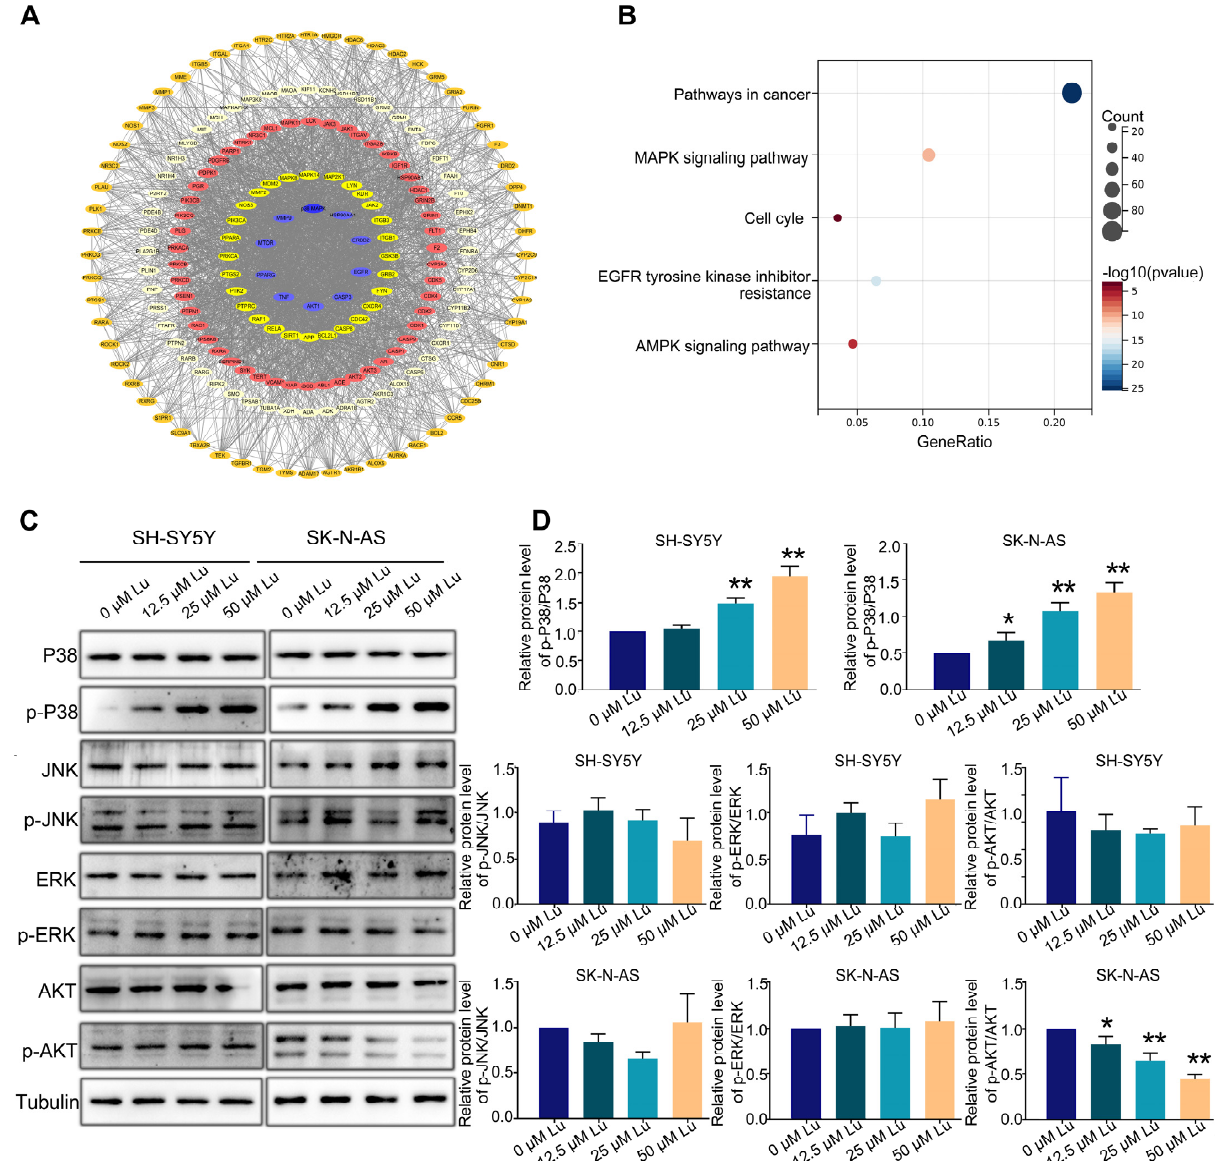
Figure 5. Luteoloside induces neuroblastoma cell cycle arrest through the p38 MAPK signaling pathway. SH-SY5Y and SK-N-AS cells were treated with different concentrations (0, 12.5, 25, and 50 µ M) of luteoloside for 24 h. ( A ) The protein–protein interaction (PPI) network of potential luteoloside targets. ( B ) Kyoto Encyclopedia of Genes and Genomes (KEGG) pathway analysis. ( C ) The protein expressions of JNK, p-JNK, ERK, p-ERK, p38, p-P38, AKT, and p-AKT were tested by Western blot. ( D ) Statistical analysis of the expression intensity of p-AKT/AKT, p-JNK/JNK, p-ERK/ERK, p-P38/P38 in SH-SY5Y and SK-N-AS cells. *, p < 0.05; **, p < 0.01. n = 3. The control group is used for comparison. Data are shown as mean ± SD.